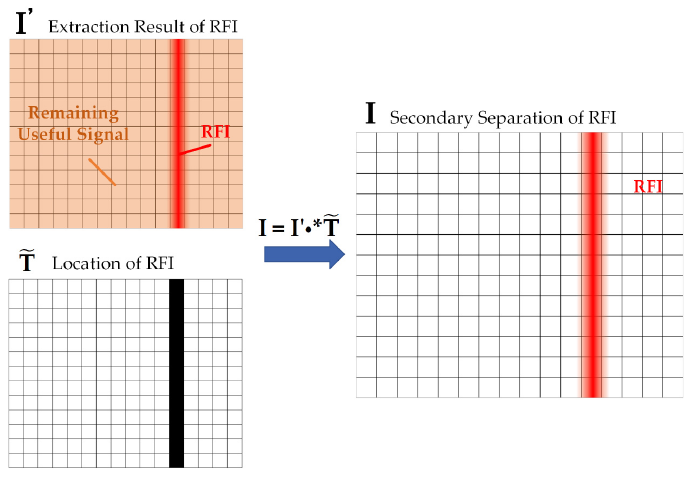
Figure 5. The secondary separation process of RFI.